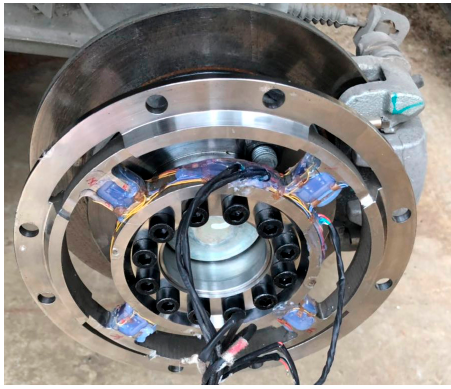
Figure 1. Spoke-type three-component force sensor.